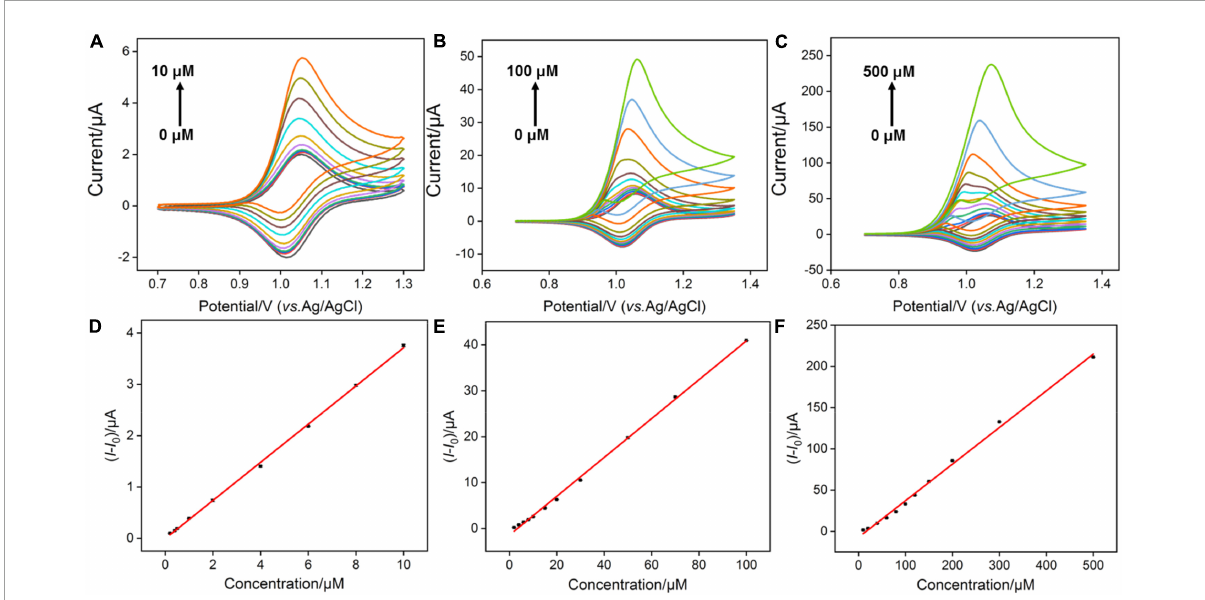
FIGURE5 (A–C) CV curves obtained at the VMSF/ITO electrode with successive addition of different concentrations of G after accumulating different concentrations of Ru(bpy) 32 + . The scan rate was 100 mV/s. (D–F) The linear relationship between the variation of anodic peak currents ( I - I 0 ) and concentrations of G. I and I 0 denote the anodic peak currents in the presence and absence of G,